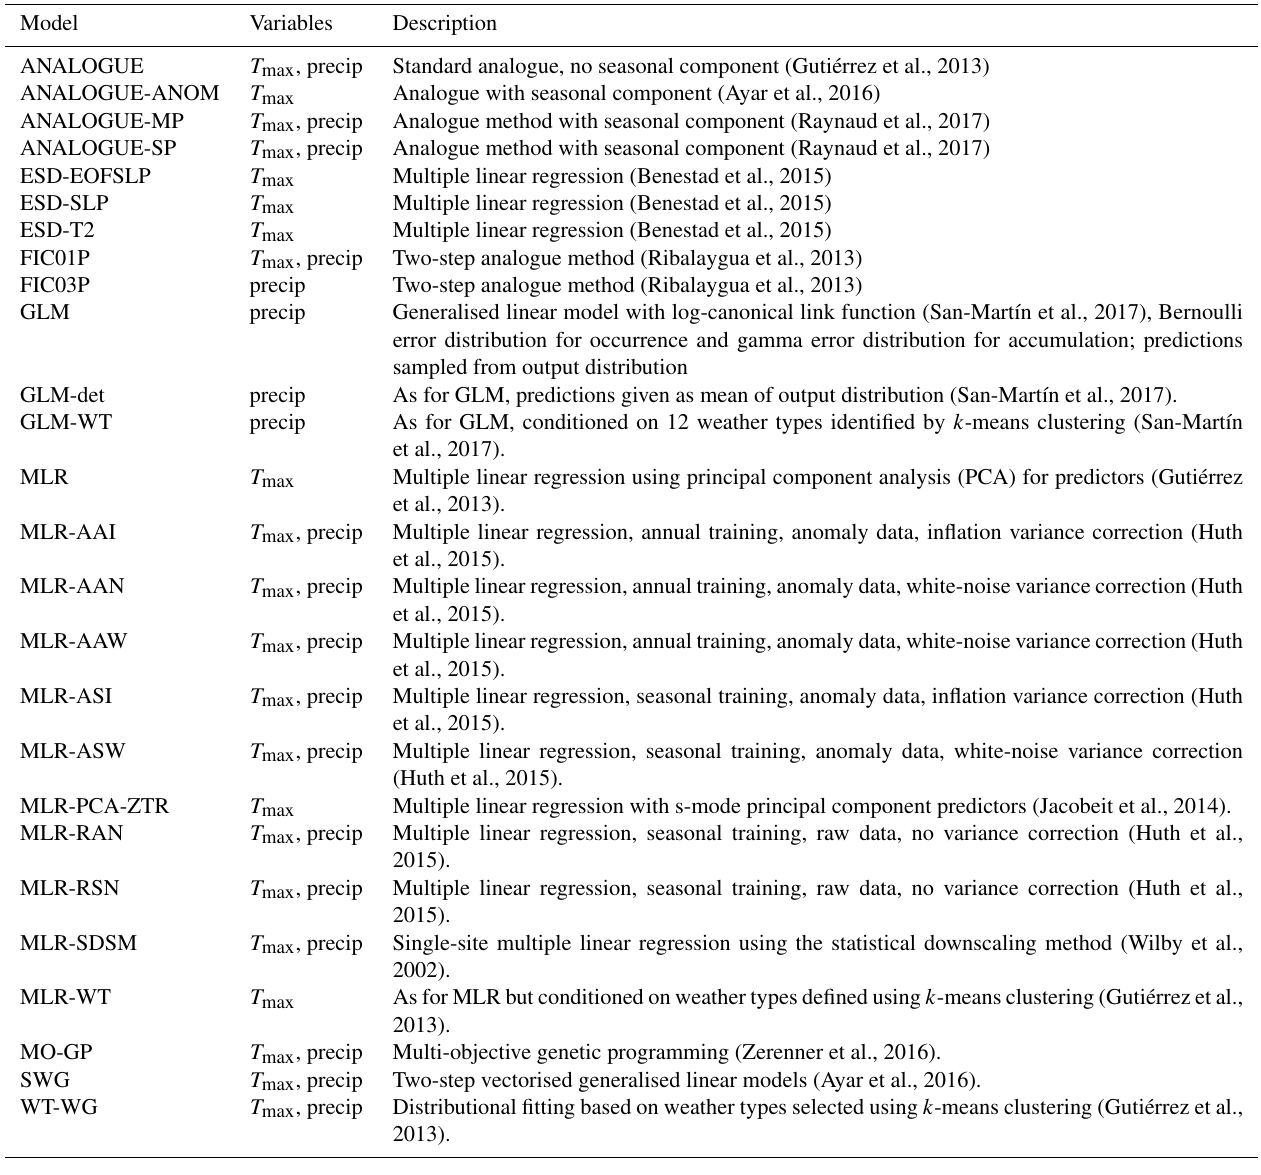
Table A1. Summary of models included in the VALUE